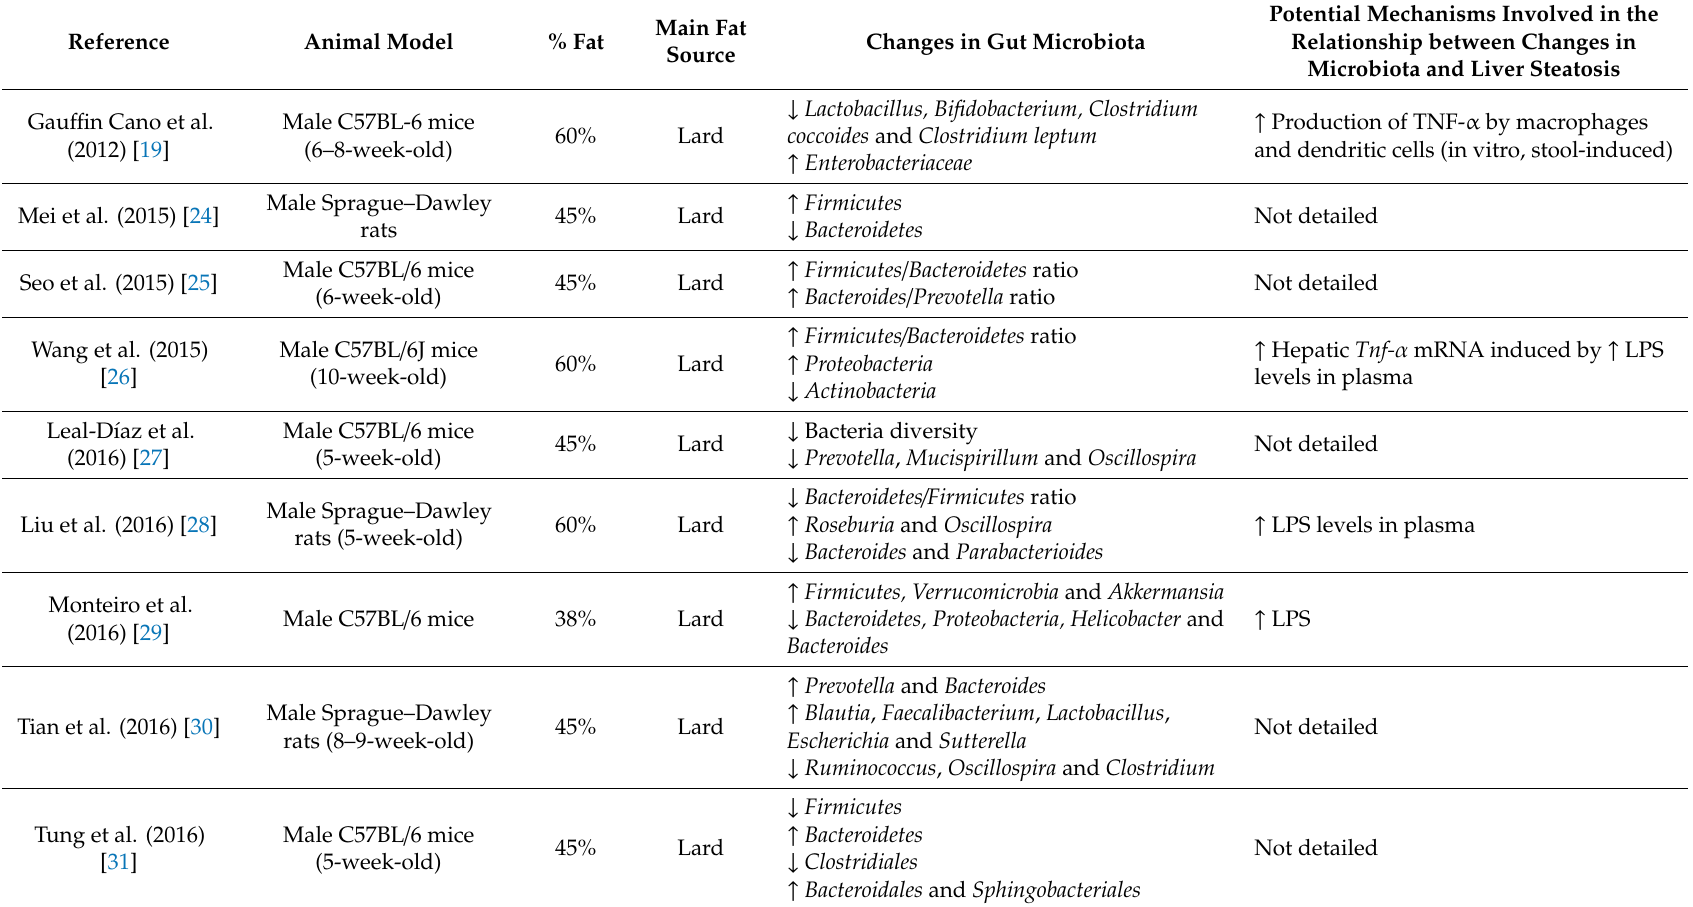
Table 1. Studies conducted in rodent models using lard-based high-fat